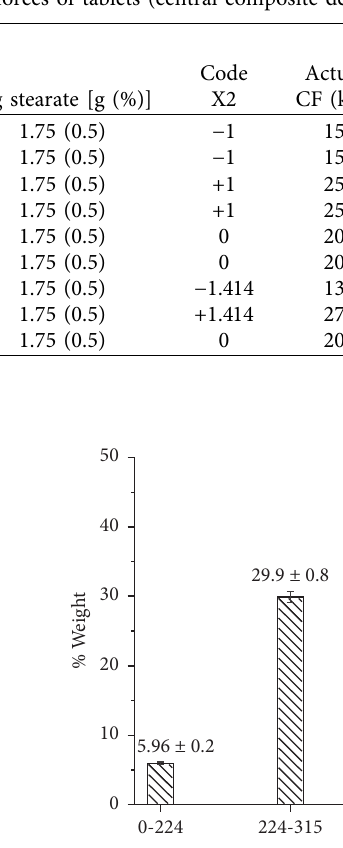
Table 1: Formulations and compression forces of tablets (central composite design).